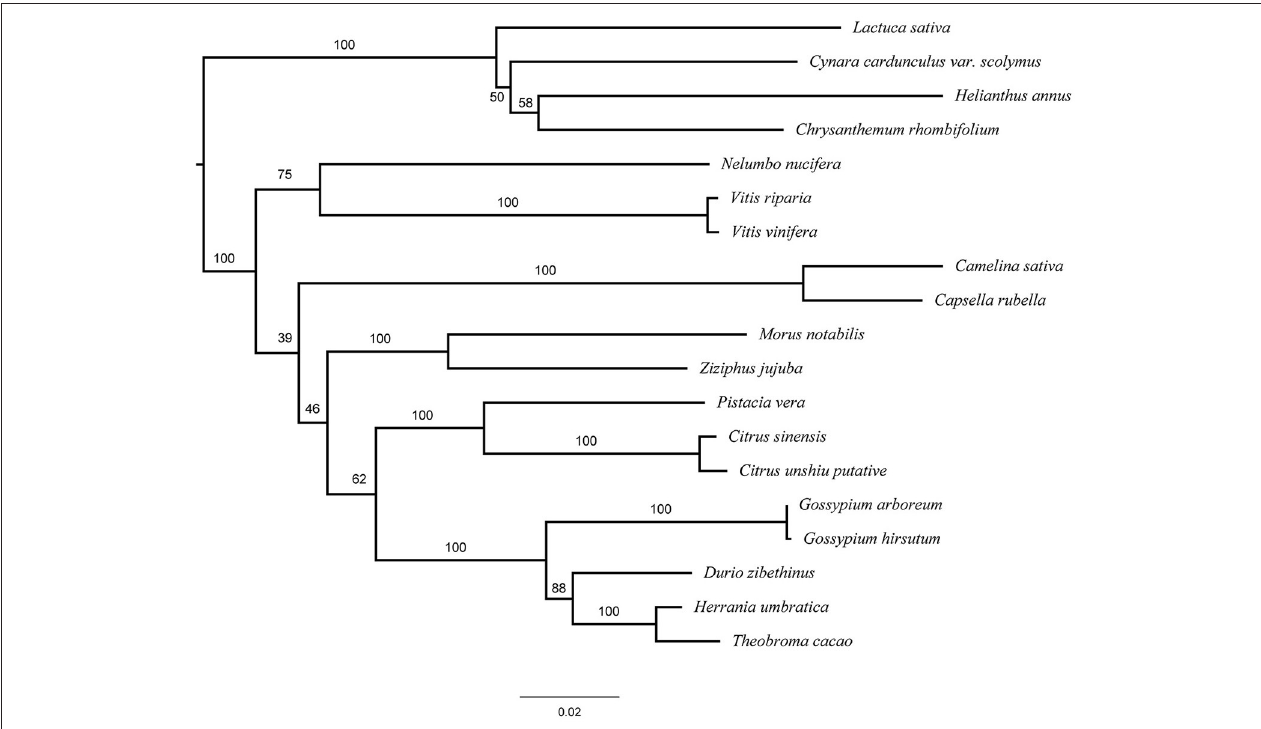
FIGURE 7 | Phylogenetic analysis of the GME in plants. Helianthus annuus XM_022174384.1; Lactuca sativa (XM_023912155.1); Cynara cardunculus var. scolymus (XM_025140401.1), Chrysanthemum rhombifolium (R|Cluster-20886.25690); Camelina sativa (XM_010456910.1); Capsella rubella (XM_006287892.2); Nelumbo nucifera (XM_010275940.2); Morus notabilis (XM_024169380.1); Vitis riparia (XM_034830226.1); Vitis vinifera (XM_002283862.4); Ziziphus jujuba (XM_016019918.2); Gossypium arboretum (XM_017764784.1); Gossypium hirsutum (XM_016869694.1); Durio zibethinus (XM_022891507.1); PREDICTED: Herrania umbratica (XM_021427500.1); Theobroma cacao (XM_018122066.1); Pistacia vera (XM_031412928.1); Citrus sinensis (XM_006471610.2); Citrus unshiu (HQ224947.1).